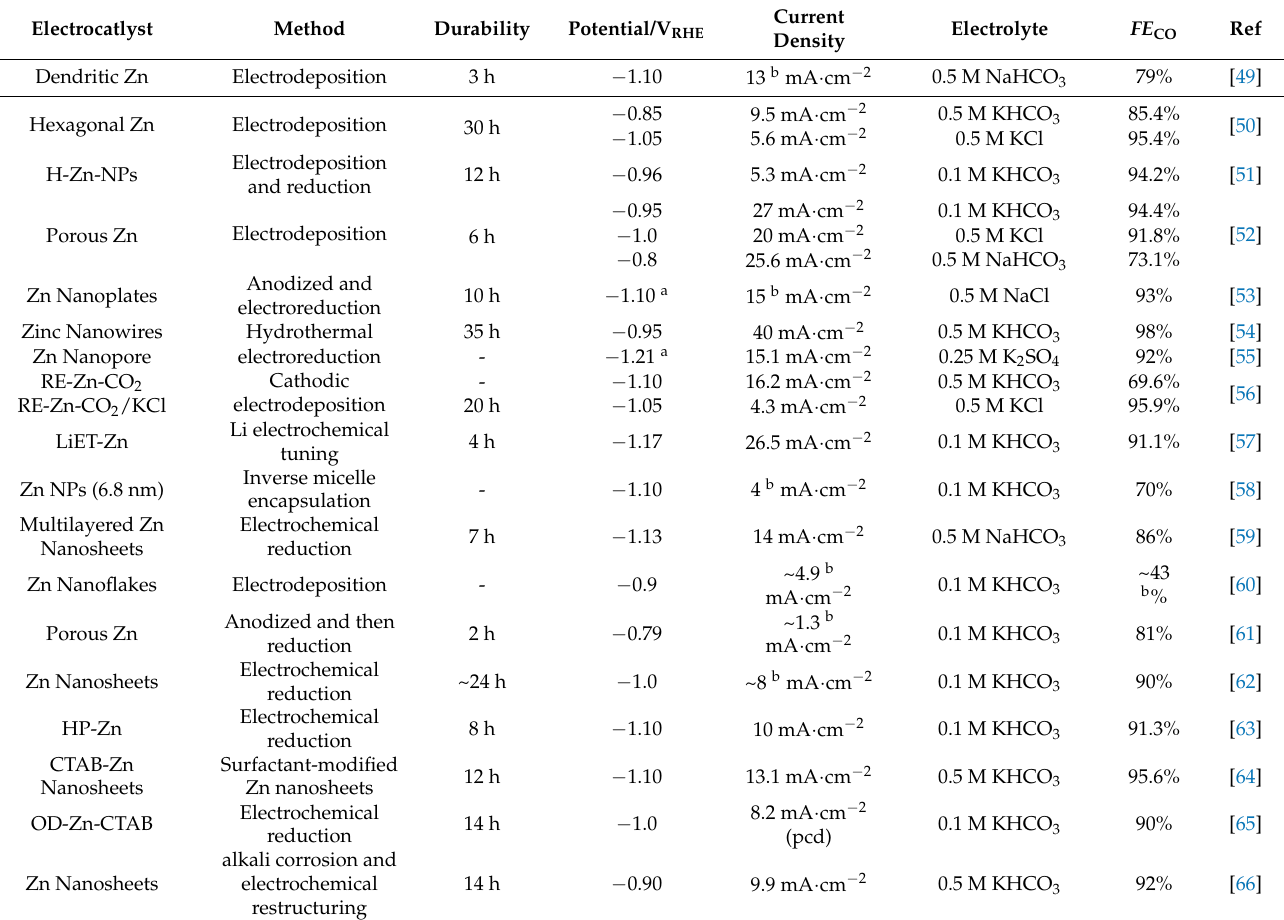
Table 2. A summary of Zn monomer catalysts for CO 2 RRs to